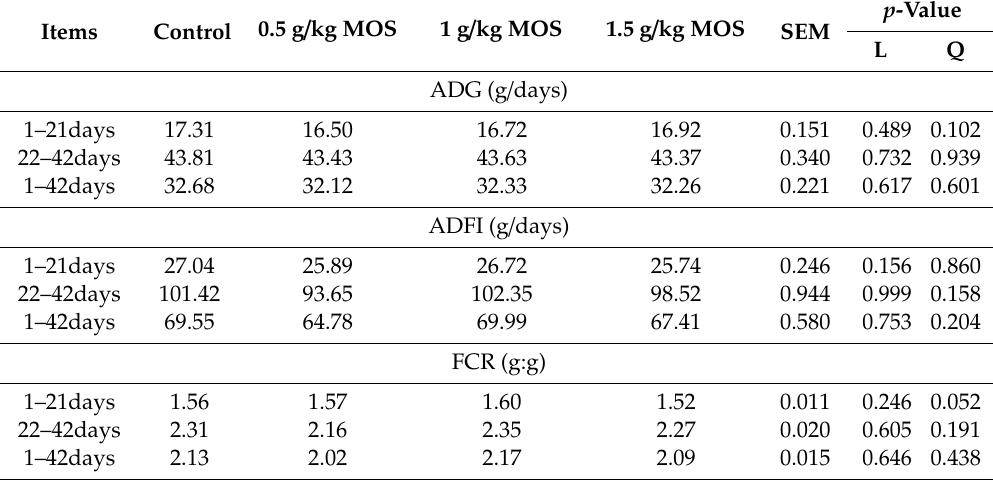
Table 2. Growth performance of Partridge Shank chickens fed diets supplemented with or without mannanoligosaccharide (MOS).